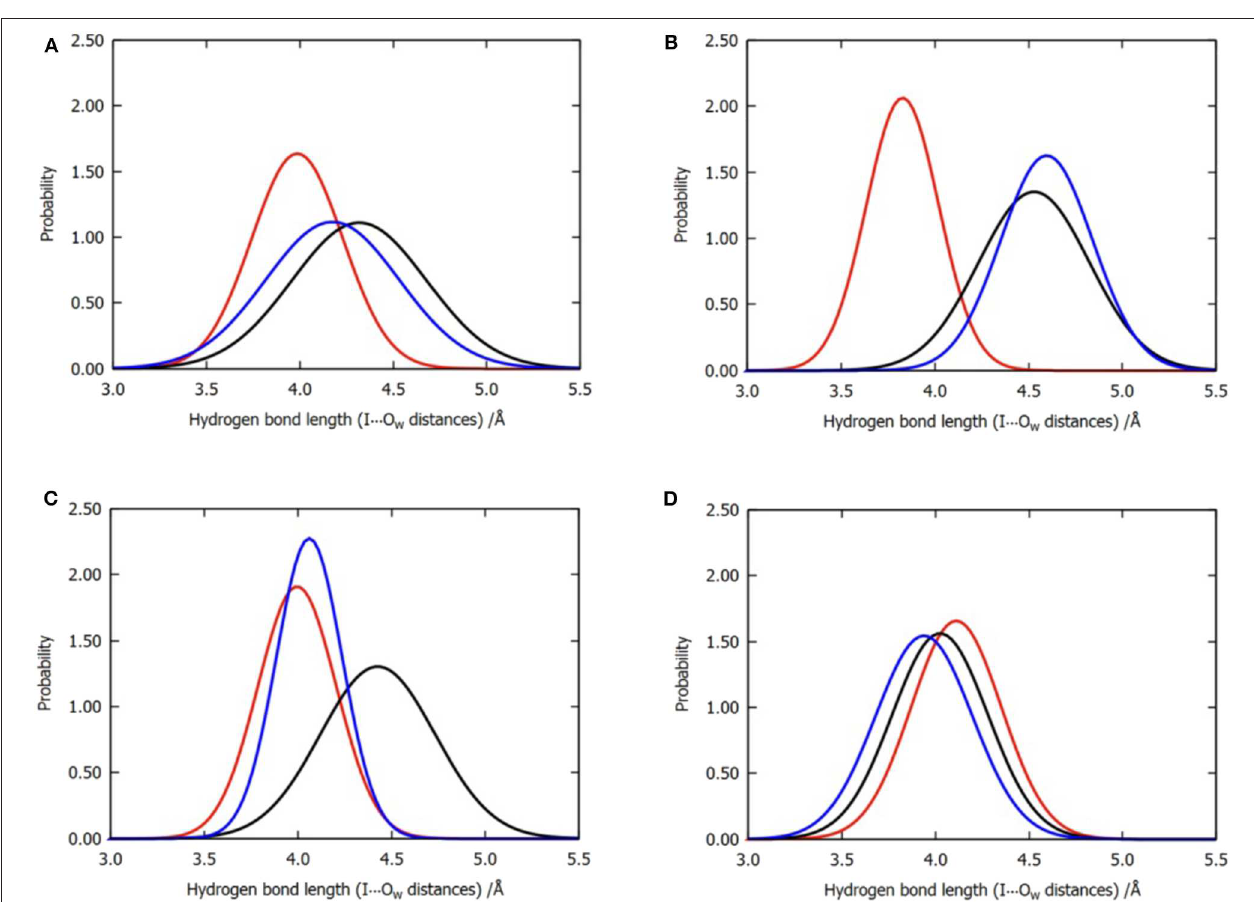
FIGURE 6 | Normalized distribution of the locations of the three water molecules near the iodine atom for all the six trajectories of model 2. (A) Overall distributions without clustering, (B) cluster A, (C) cluster B, and (D) cluster C. Color code: red, W1; black, W2; blue, W3.